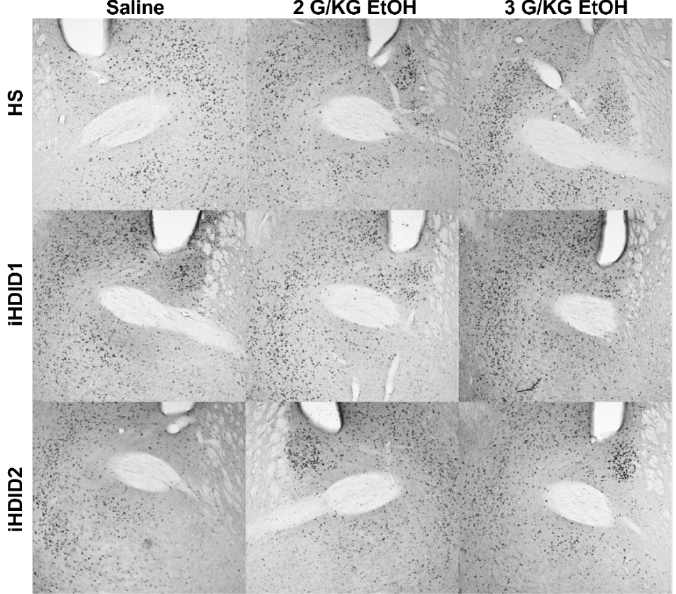
Figure 7. Bed Nucleus of the Stria Terminalis. Representative images of c-Fos expression in the BNST across genotype and treatment types. across genotype and treatment